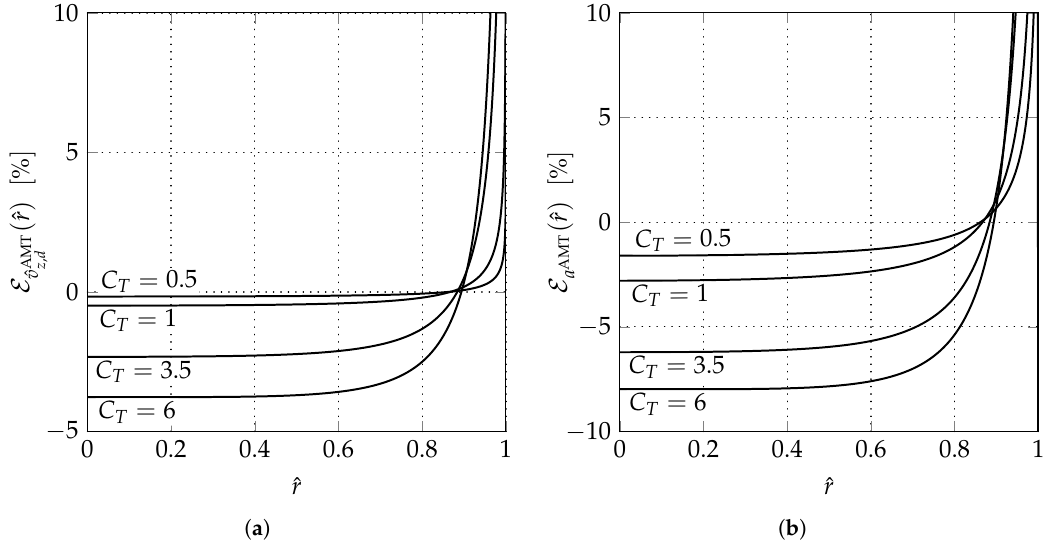
Figure 11. ( a ): percentage relative error on the dimensionless axial velocity at the disk. ( b ): Percentage relative error on the axial induction